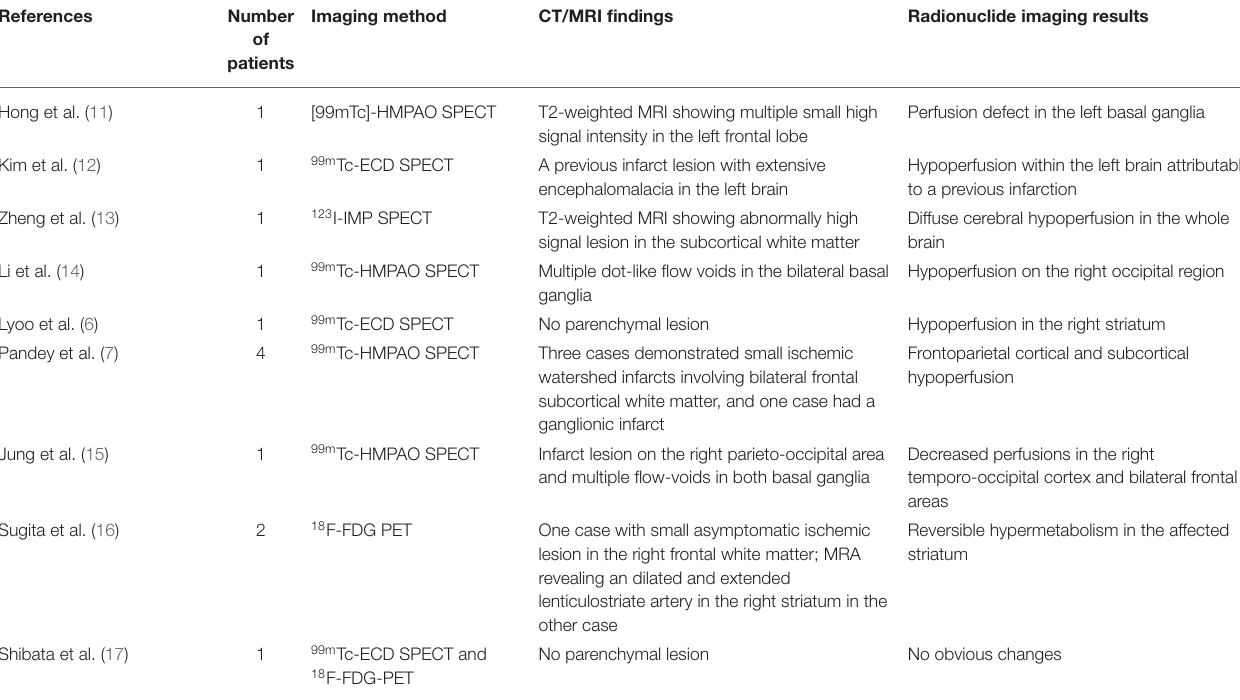
TABLE 1 | Summary of published case-series of radionuclide imaging of MMD-induced